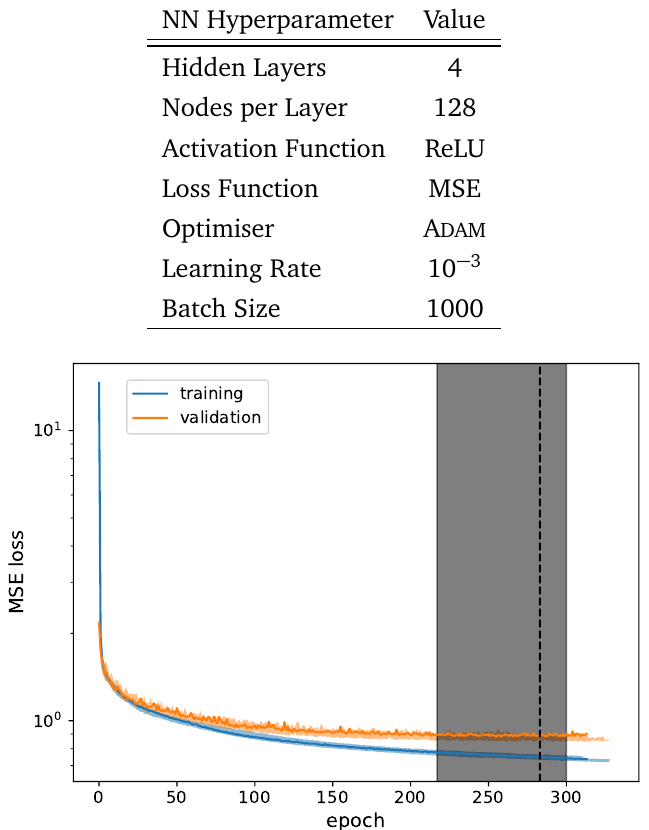
Figure 2: Training (blue) and validation (orange) MSE loss of the best performing NN during training. The dashed line illustrates the stopping point due to early stopping. The coloured bands show the variations from ten independently trained initialisa- tions of the same